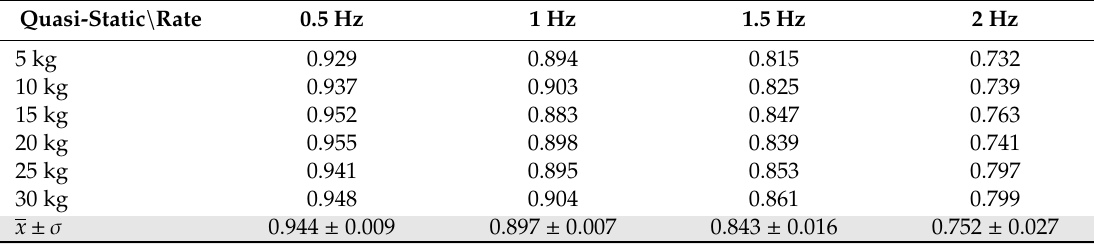
Figure 7. Hysteresis based on empirical model and experimental tests at all dependencies. Table 3. Correlation test at all dependencies.